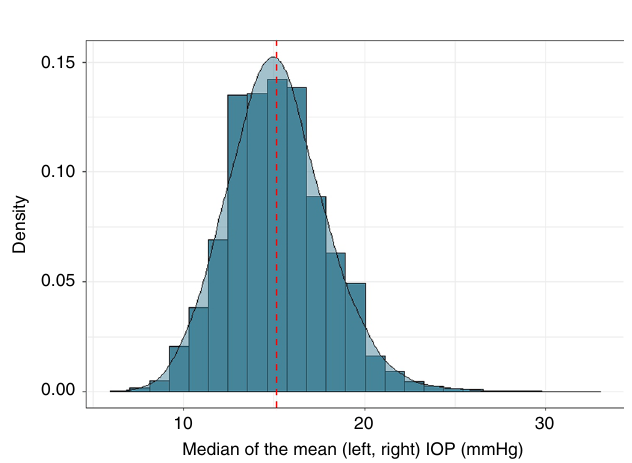
Fig. 1 Distribution of the median of the mean (left, right) of IOP in GERA cohort subjects. A total of 356,987 IOP measurements from 69,756 individuals were used to create this chart showing the normal distribution of the median of the IOP mean from both